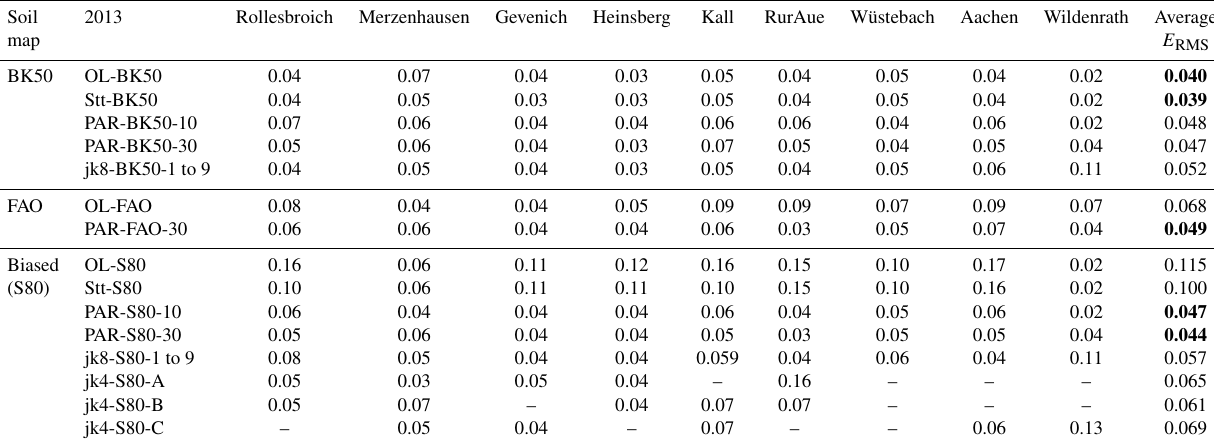
Table A2. E RMS (cm 3 cm − 3 ) at CRNS sites for open loop, data assimilation and jackknife simulations on the basis of a comparison with CRNS SWC retrievals for the verification period (2013). For jackknife experiments (21 in total) only the error of the omitted sites is reported. The best cases are marked in